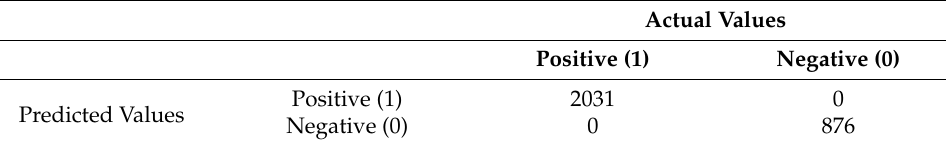
Table 8. Random forest confusion matrix.